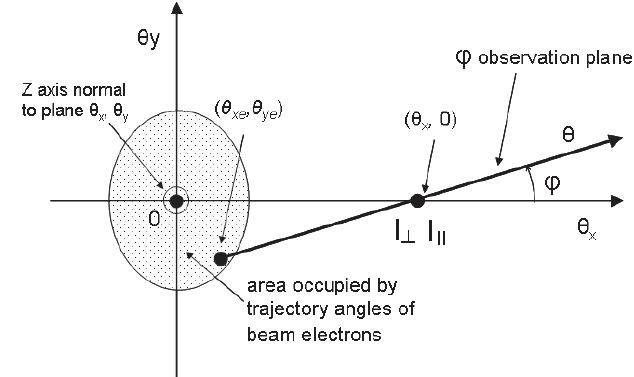
FIG. 4. Schematic of the observation plane, showing the angular space occupied by the beam electrons and the (cid:5) , (cid:12) scan direction for a single electron trajectory angle in this